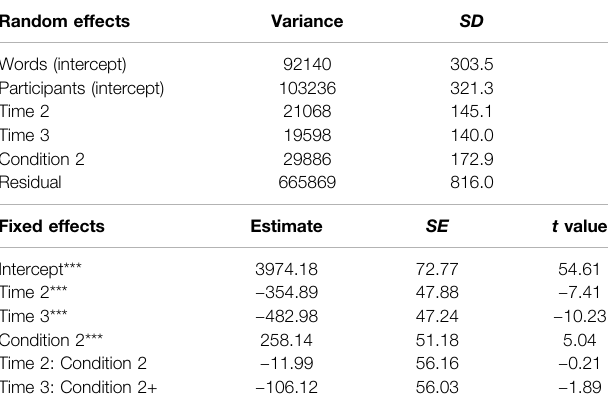
TABLE3| AllthecontrastsoftheperformancesofChinesewordandpicturepairs (CP) and Chinese word and Japanese word pairs (CJ) in recognition tasks. Contrast Estimate